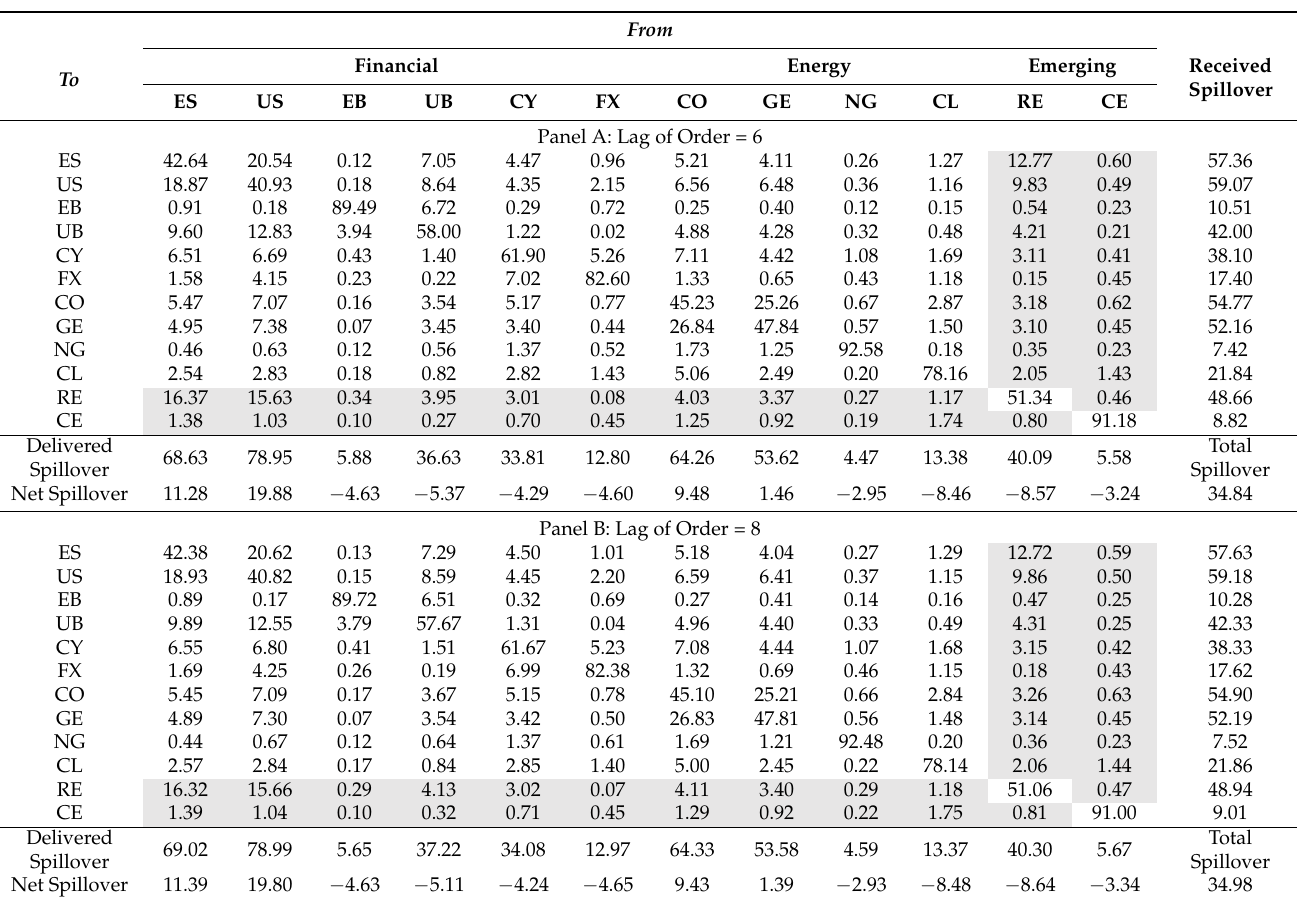
Table 7. Spillover Indexes of All Markets, Robustness Check.